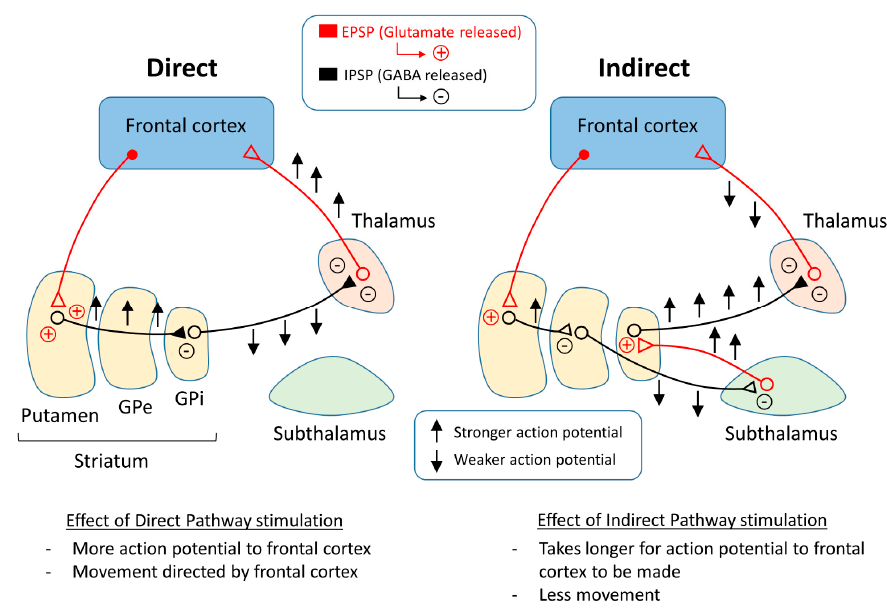
Figure 3: Basal ganglia circuitry regulating the direct and indirect pathways